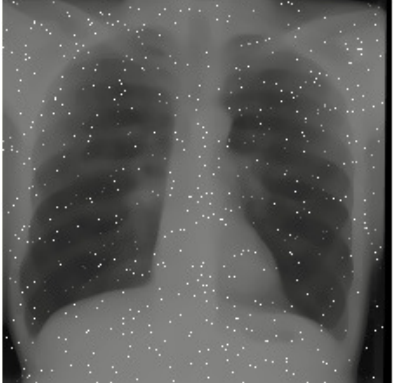
Figure 5. Image Quality augmentation on X-ray from